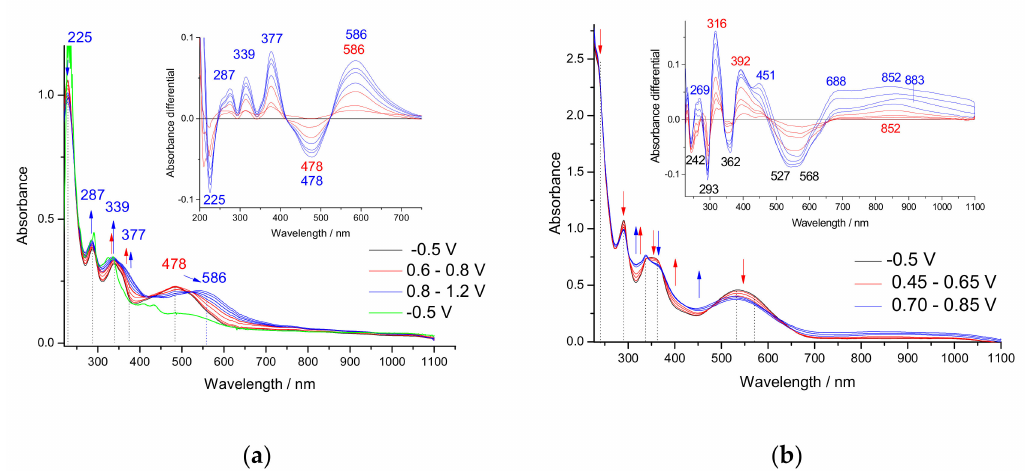
Figure 5. Change in absorbance of UV-Vis-NIR under polarization of diradical dication ( red ) and triradical trication production ( blue ) of 1 ( a ) and 2 ( b ) in 1mM solution of monomer in 0.1 M Bu 4 NBF 4 /DCM solution; difference absorbance vs wavelength ( inserts) ; neutral p(1)-II under -0.5 V polarization ( green